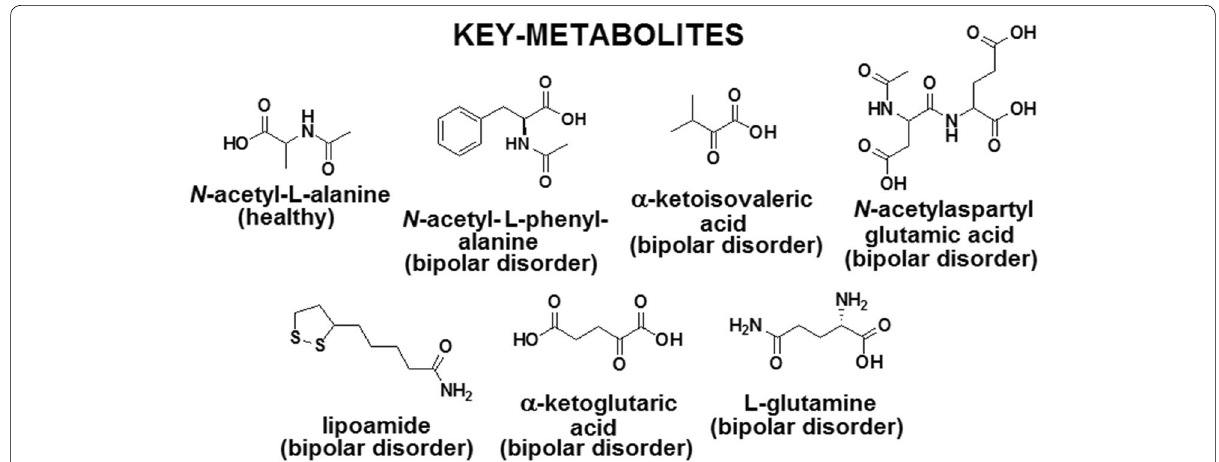
Fig. 4 Chemical structures of seven key‑metabolites (1 from HC group